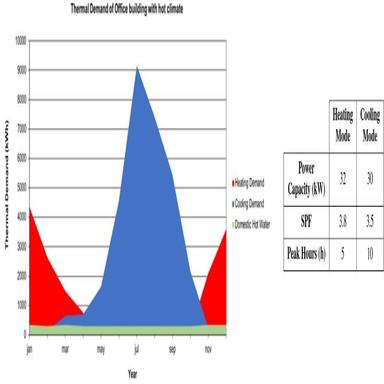
Thermal loads for an office building in a hot climatic region.